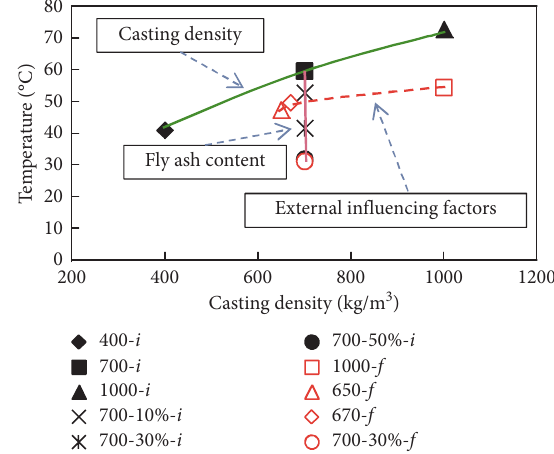
Figure 18: Maximum temperature increments of the foamed concrete. Note: 700-10%-i denotes the value with a casting density of 700kg/m 3 with 10% content of fly ash and the indoor model test. 700-10%-f denotes the value with the casting density of 700kg/m 3 with 10% content of fly ash and the field